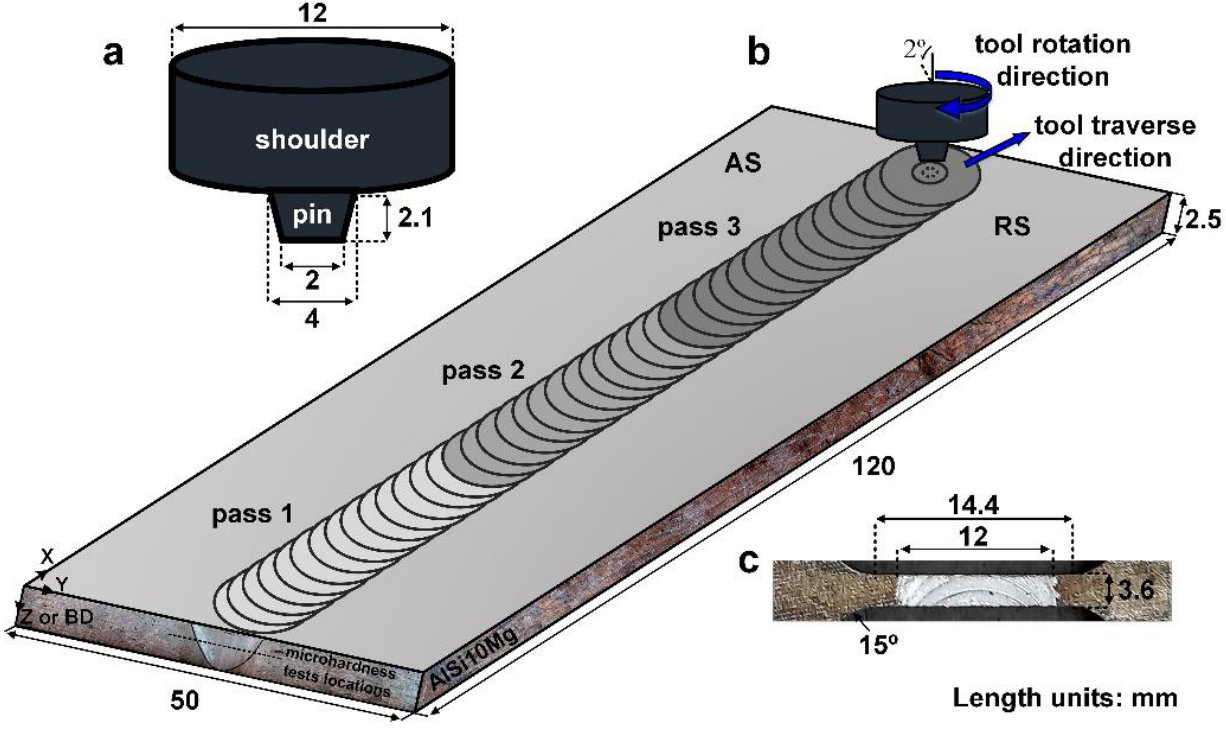
Figure 1. Schematics of ( a ) FSP tool, ( b ) FSP process, and ( c ) tensile test samples. The macrostructure and microstructure of the joint were characterized using optical microscopy, scanning electron microscopy (SEM) equipped with an electron backscatter diffraction (EBSD) unit, and X-ray diffraction (XRD). Metallographic samples were cut from the joint perpendicular to the FSW direction, polished, and etched with a solution